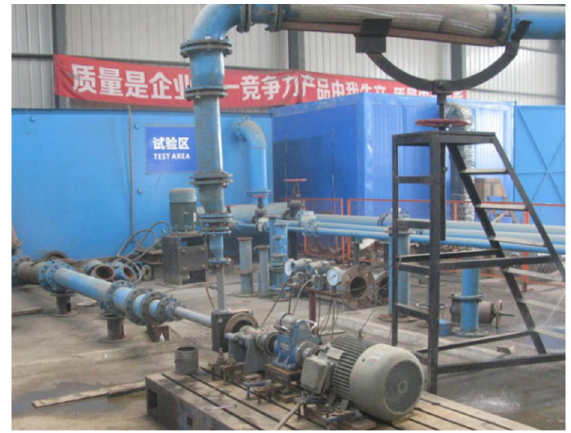
Figure 3. Hydraulic performance test bench.